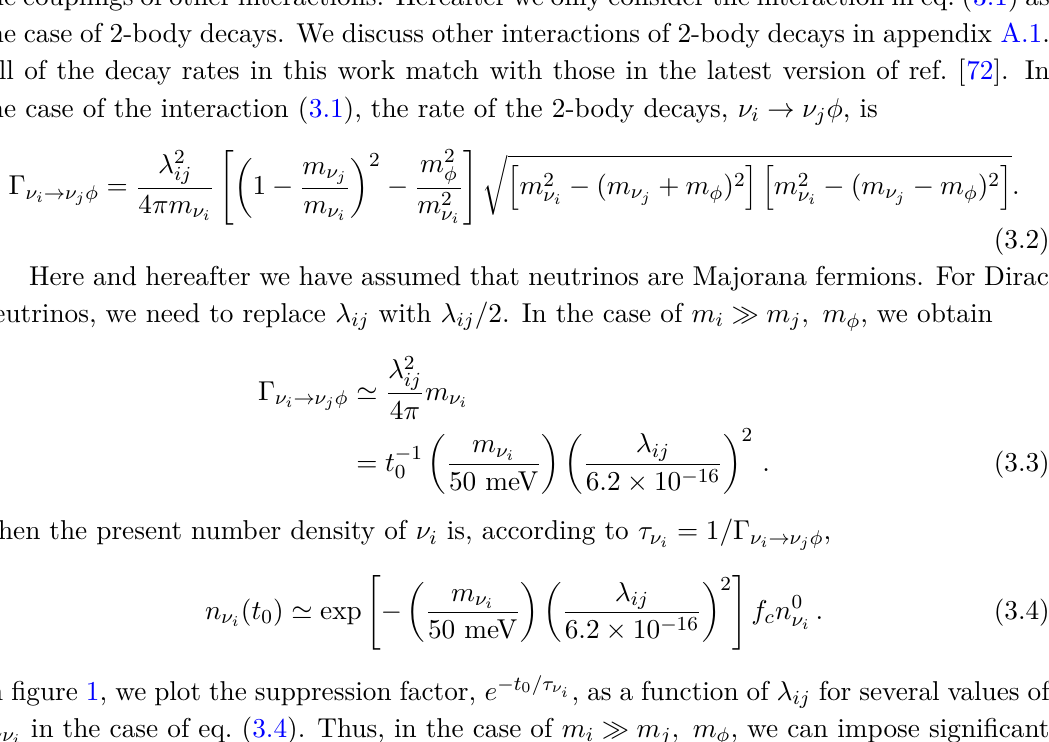
Figure 1 . Suppression factor, e − t 0 /τ νi , as a function of λ ij for several values of m ν eq.